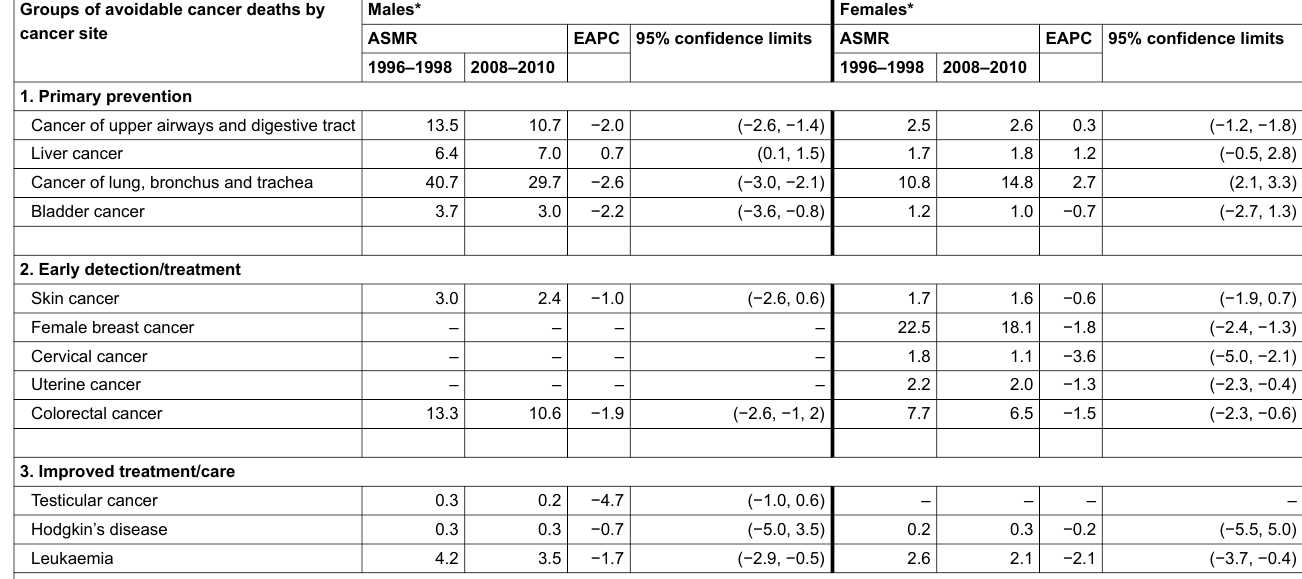
Table 4: Swiss cancer-specific age-standardised mortality rates per 100 000 person-years (European standard) for time periods 1996–1998 and 2008–2010 with estimated annual percentage changes 1996–2010 by sex and group of avoidable cancer deaths. Males* Females* EAPCGroups of avoidable cancer deaths by cancer site ASMR EAPC ASMR 95% confidence 1996–1998 2008–2010